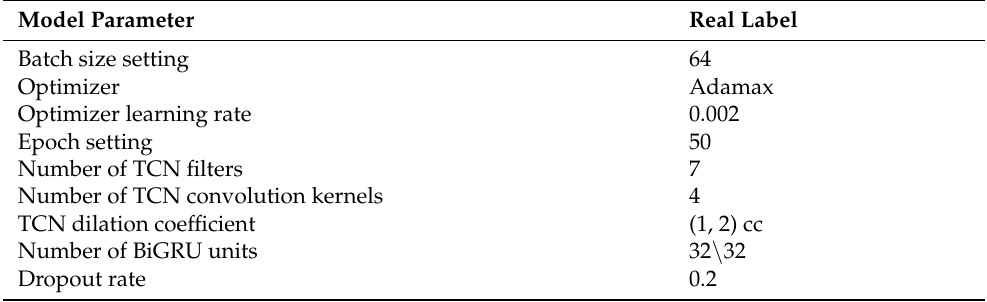
Table 3. Parameter setting of